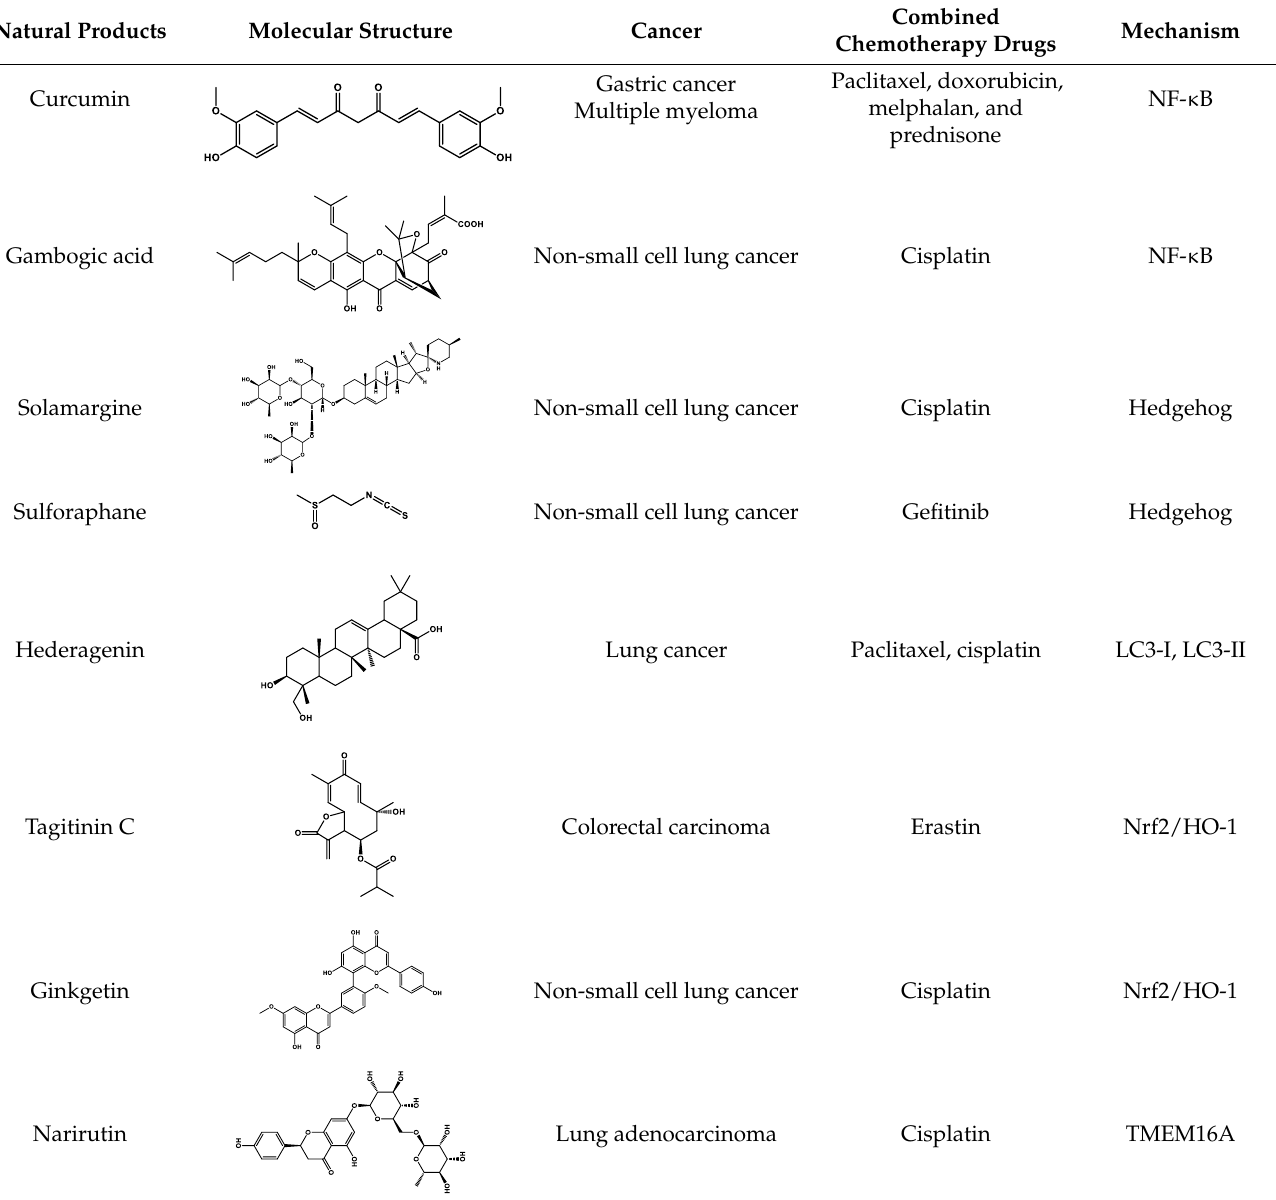
Table 1. Natural compounds that synergistically enhance the effects of cancer chemotherapy and their mechanisms.